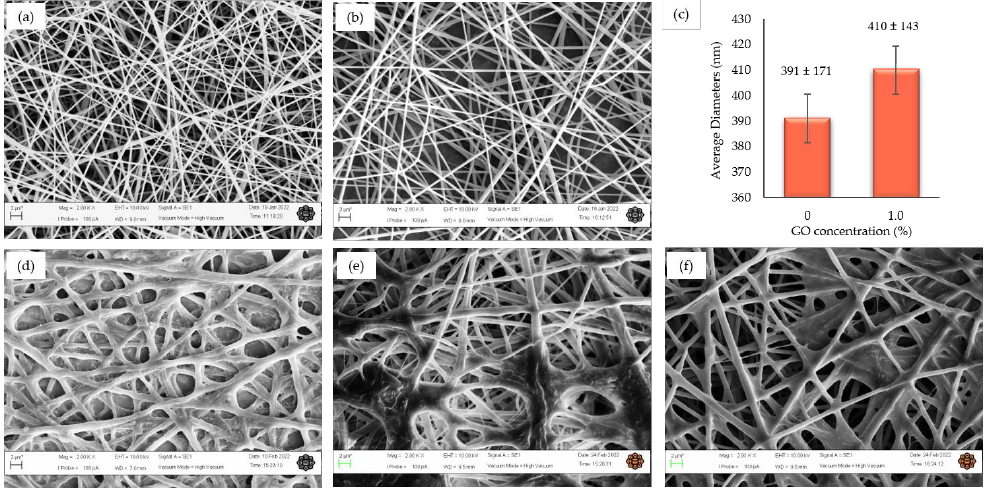
Figure 2. SEM images of ( a ) PCL/gelatin (PG); ( b ) PGO nanofibers; ( c ) average diameters of PG and PGO nanofibers; ( d ) PGO-M1; ( e ) PGO-M2; ( f ) PGO-M3 nanofibers at 2000 magnification (scale bar: 2 µm).